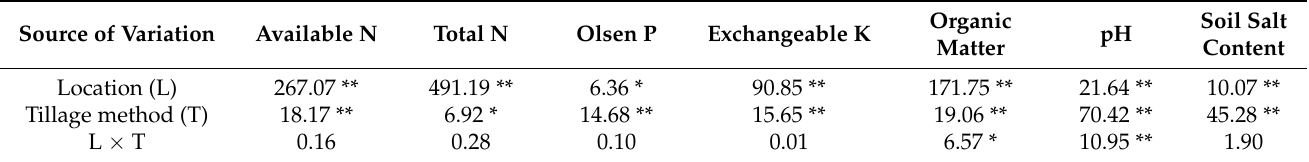
Table 2. Variance analysis of soil physical and chemical properties with each treatment (F-value).